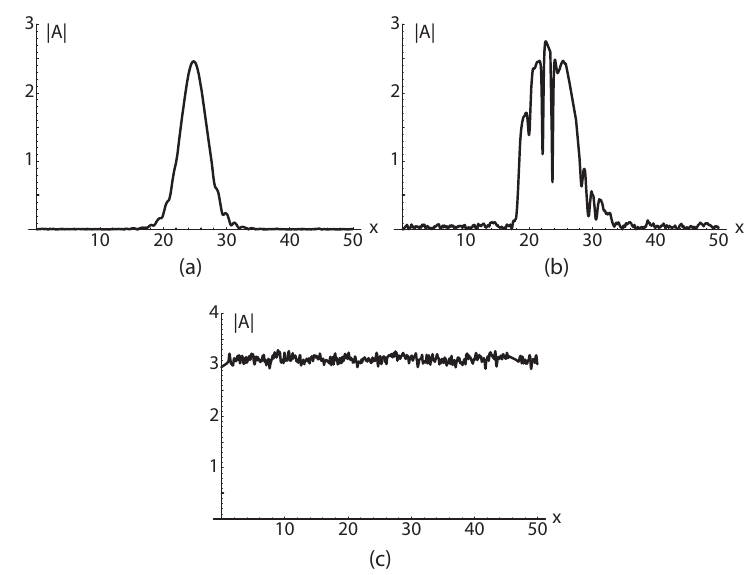
Figure 2. Three snapshots for µ = − 0.25 and additive noise for different values of the noise strength η . ( a ) Noisy non-explosive localized solution, η = 0.003; ( b ) Exploding dissipative solution, η = 0.03; ( c ) Noisy spatially homogeneous finite amplitude solution, η =